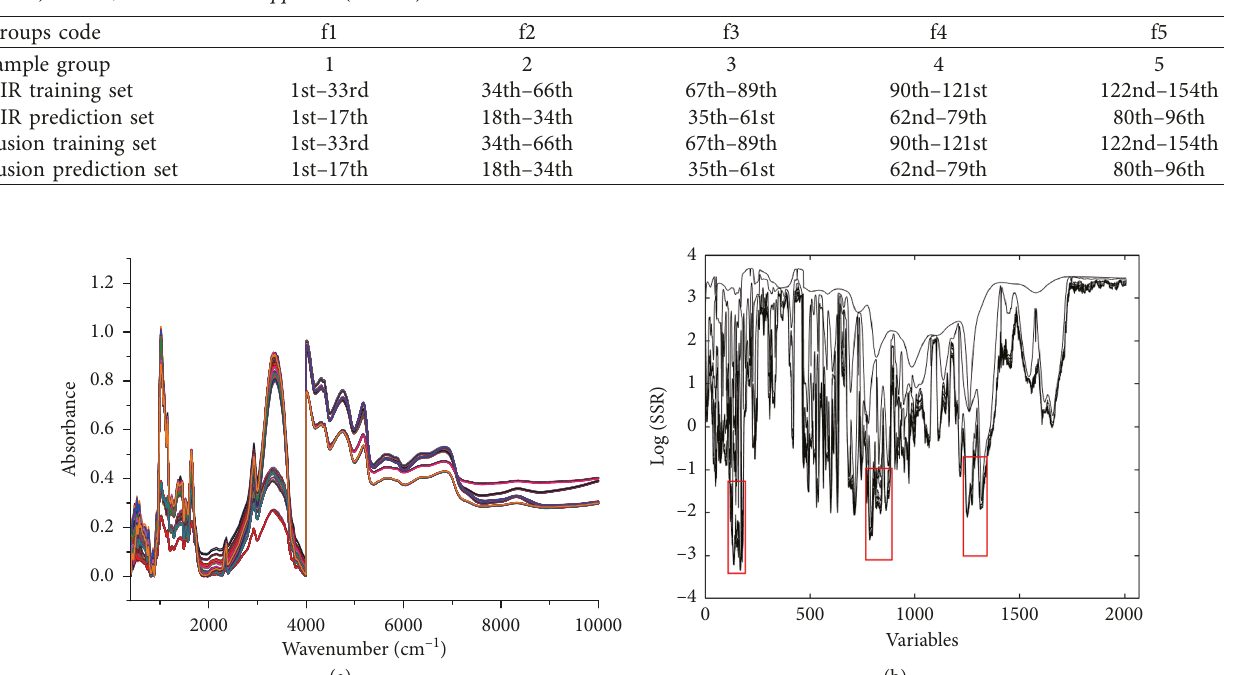
Table 2: A detailed list of two kinds of Corydalis yanhusuo W. T. Wang, Corydalis decumbens (Thunb.) Pers., Typhonium flagelliforme